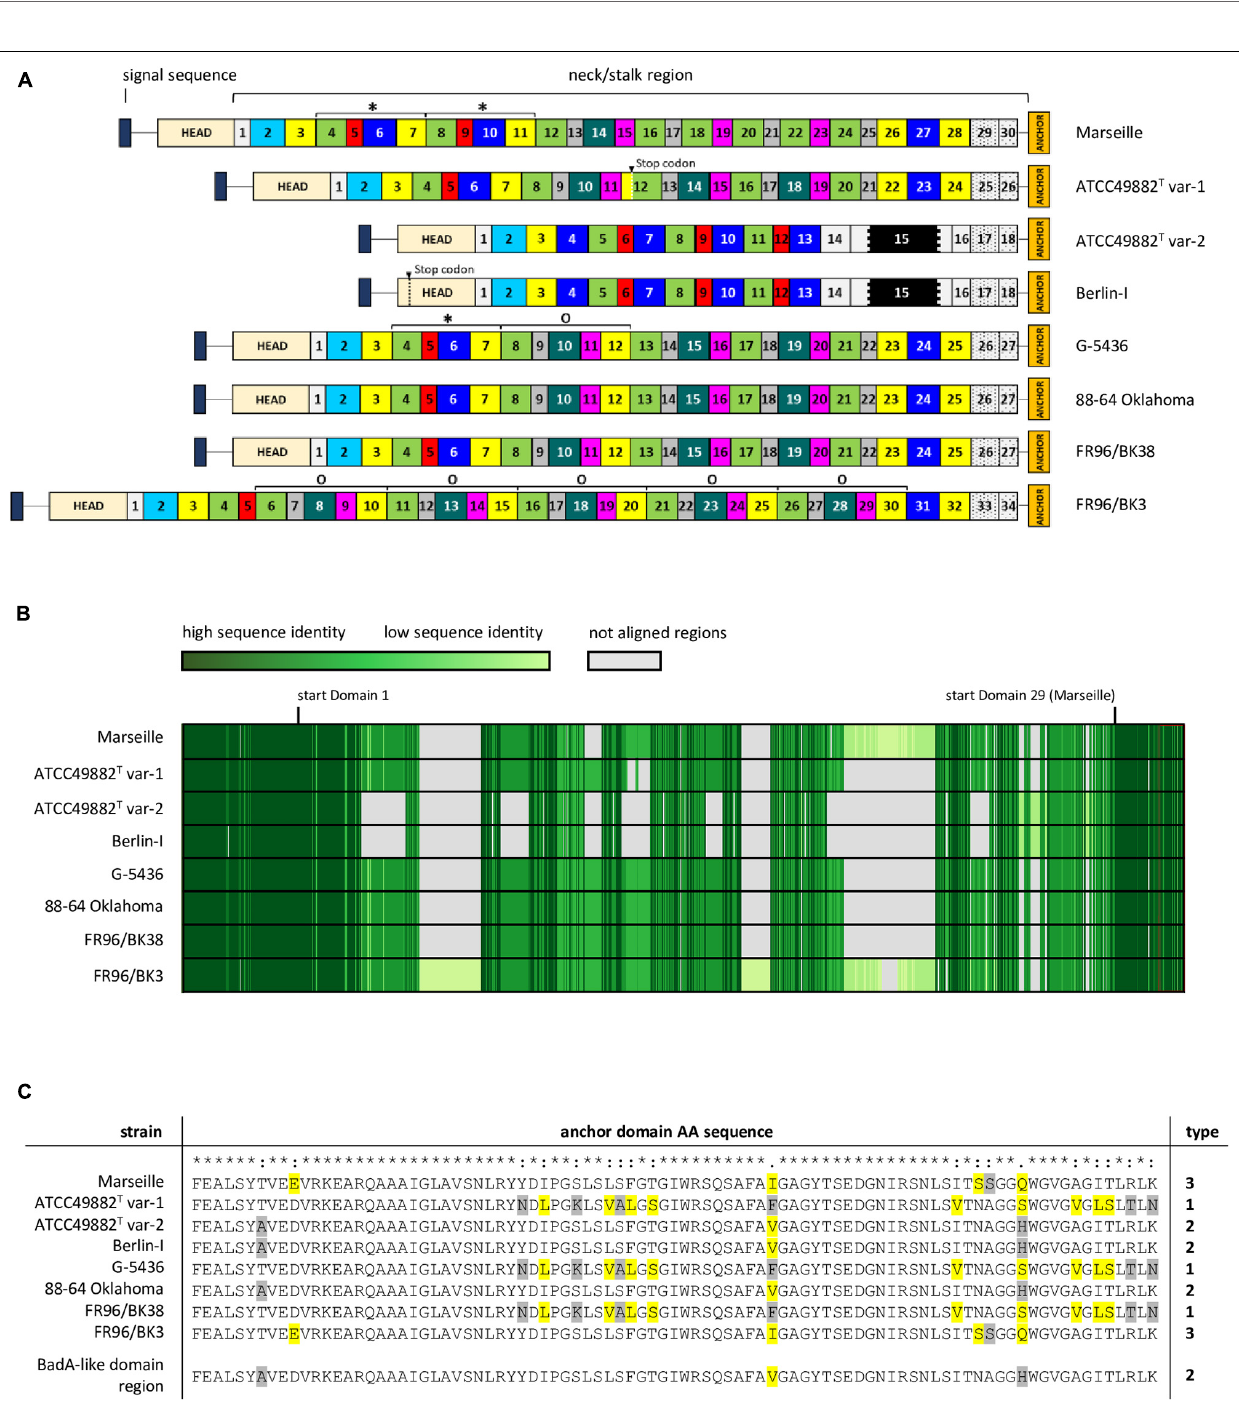
FIGURE 3 | Schematic comparison and aa-alignment of deduced BadA protein sequences among eight B. henselae strains. (A) BadA subdivided in numerous predicted domains based on the typical neck sequences demonstrates the high number of repeated motifs within a single protein, as well as among the various tested strains ( ∗ and O ). Each domain colour represents a domain category that show mutual protein sequence similarity. The neck/stalk region, where domains are presumably multiplied, deleted, or recombined via recombination events, is diverse among the strains. Due to a frameshift mutation, a stop codon is observed in BadA domain 12 of strain ATCC49882 T var-1, and in the head domain of strain Berlin-I. The black region within domain 15 in strains ATCC49882 T var-1 and Berlin-I represents the unique 18 nt-long repeat sequence motif. (B) BadA protein sequence alignment (MUSCLE) shows a conserved N-terminal (ca. first 1,000 aa) and C-terminal region (ca. last 330 aa) with a higher diversity observed in the BadA neck/stalk region. (C) Protein sequence alignment (MUSCLE) of the anchor domain reveals the presence of three different types (1, 2, and 3). Highlighted aa show differences among aligned sequences that share similar biochemical properties (yellow), or that do not